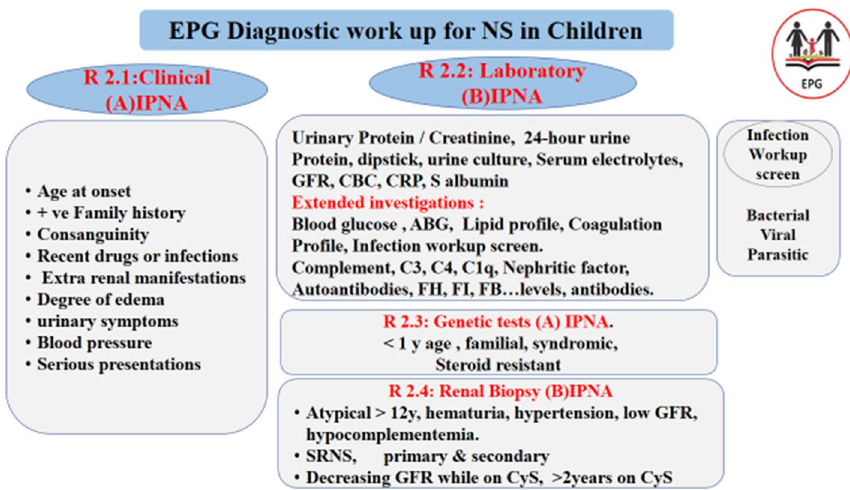
Fig. 1 Diagnosis workup for nephrotic syndrome in